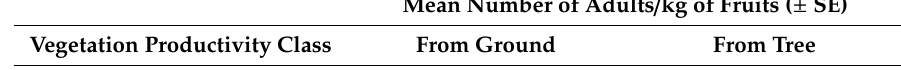
Table 2. Infestation index for Ceratitis cosyra of the ground and tree-collected fruits across landscape vegetation productivity classes.